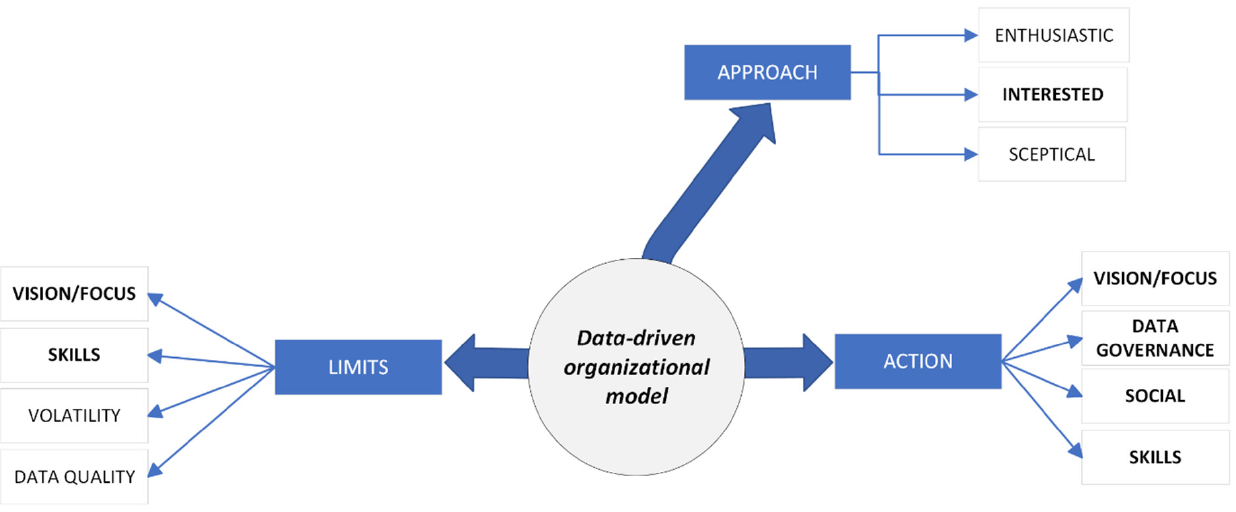
Figure 3. Data-driven organizational model.